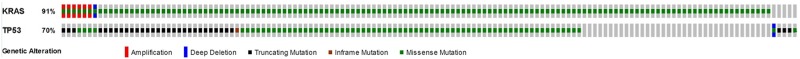
The OncoPrint tab.